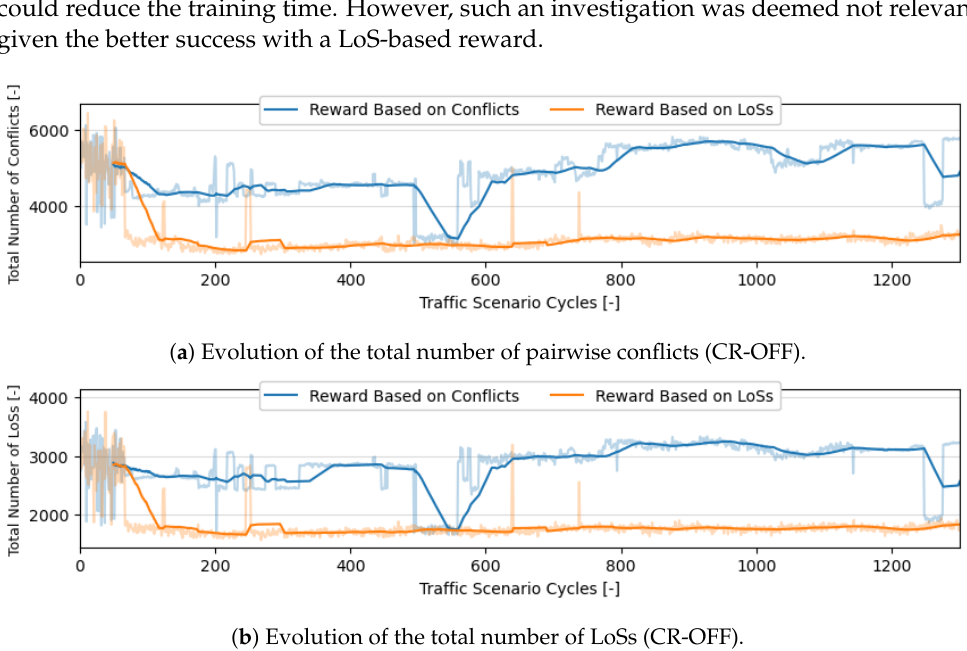
Figure 9. Evolution during training of two RL agents—one trained based on the number of conflicts (in blue) and the other on the number of LoSs (in orange). Conflict resolution was not applied in this